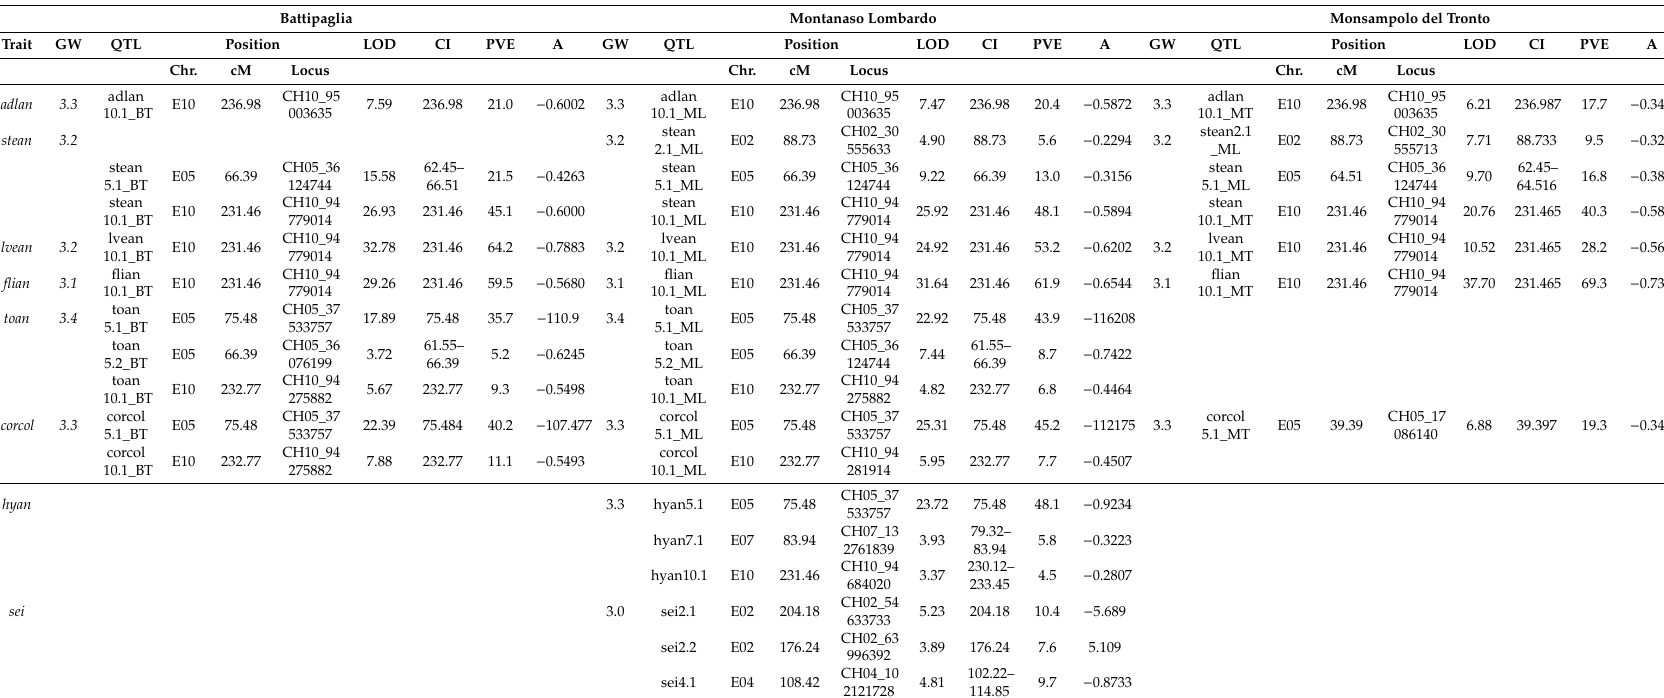
Table 4. QTL detected in the mapping population. For each trait the chromosomal location (Chr.), the genome-wide thresholds (GW) at p = 0.05 (as determined from 1000 permutations) are